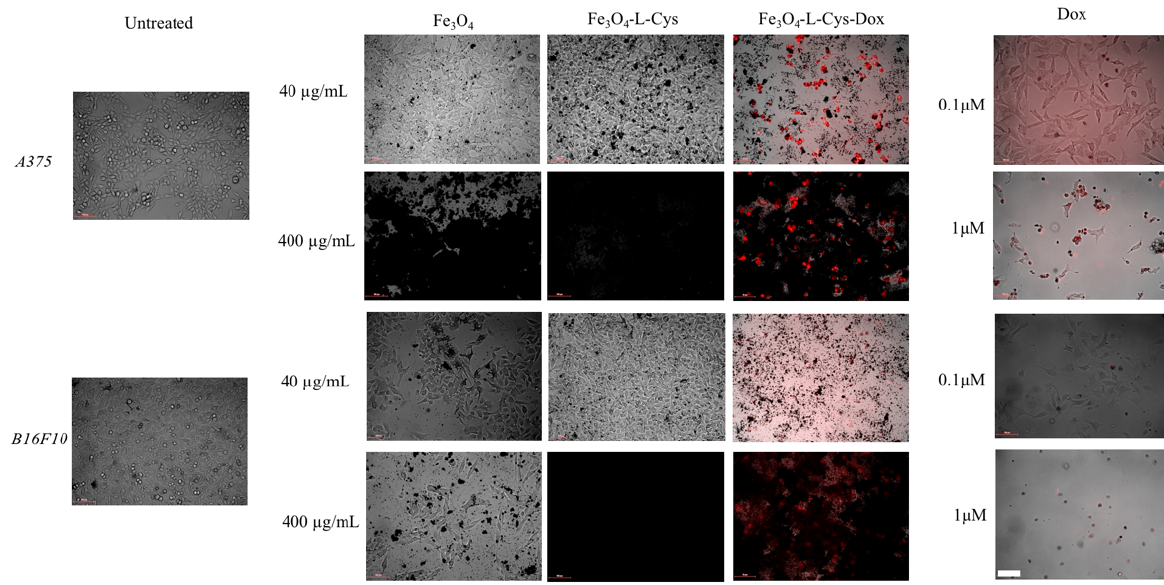
Figure 10. Dox internalization upon treatment with drug-loaded NPs versus free drug. Brightfield superimposed with immunofluorescence images, showing the presence of Dox in cells 48 h after treatment. Scale bar = 100 µm.